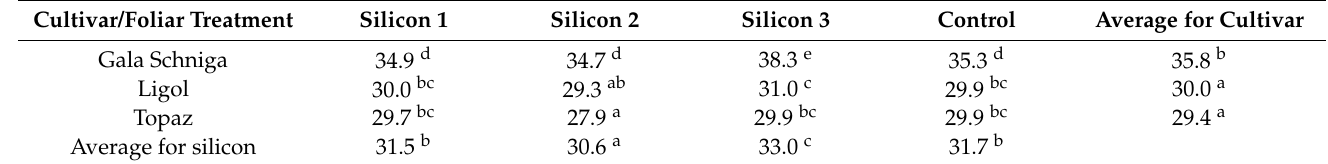
Table 9. The fruits ‘a’ parameter depend on cultivar and foliar silicon